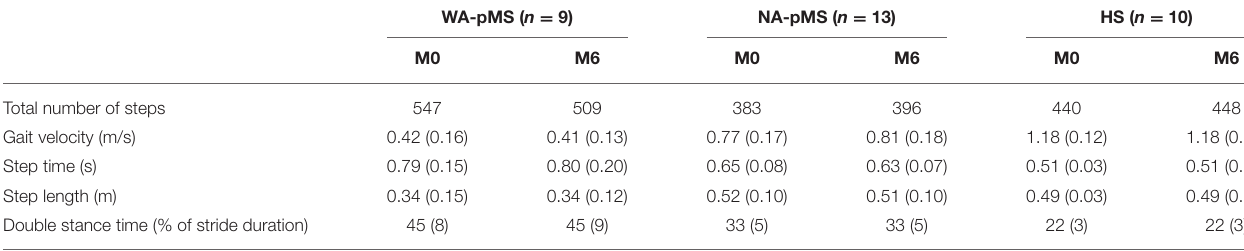
TABLE 2 | Number of steps and mean (sd) of gait velocities, step time, step length, and double stance time for all